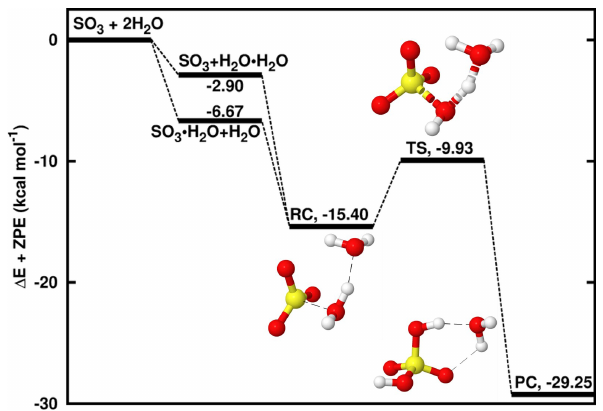
Figure 1. Energy surface for the water-catalyzed SO 3 hydrolysis. “RC” stands for pre-reactive intermediate; “TS” is transition state and “PC” is product complex. Color coding is yellow for sulfur atom, red for oxygen atom and white for hydrogen atom. Electronic energy values of all intermediates are indicated, and corresponding Gibbs free values are given in Table S4 in the